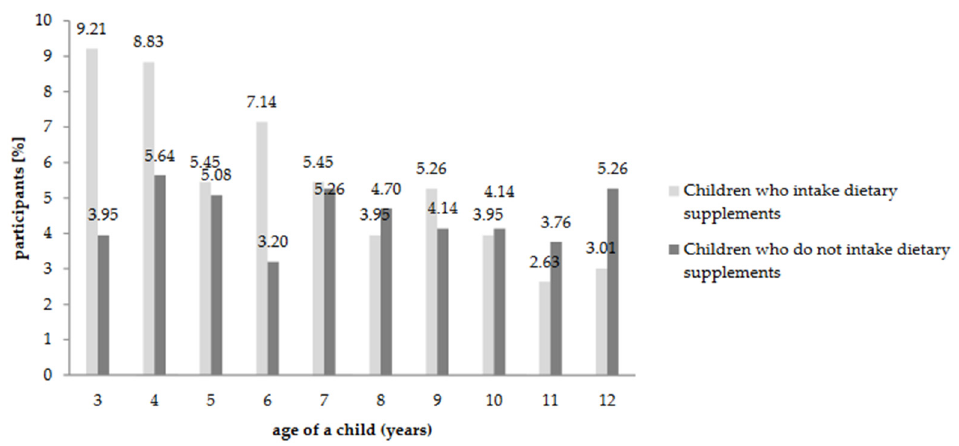
Figure 1. Relationship between child’s age and the child taking dietary supplements.